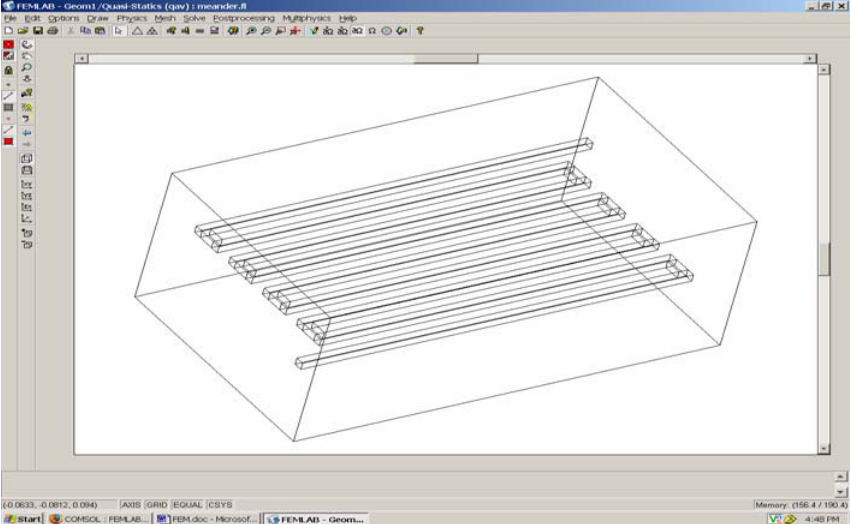
Figure 10. Model of meander type